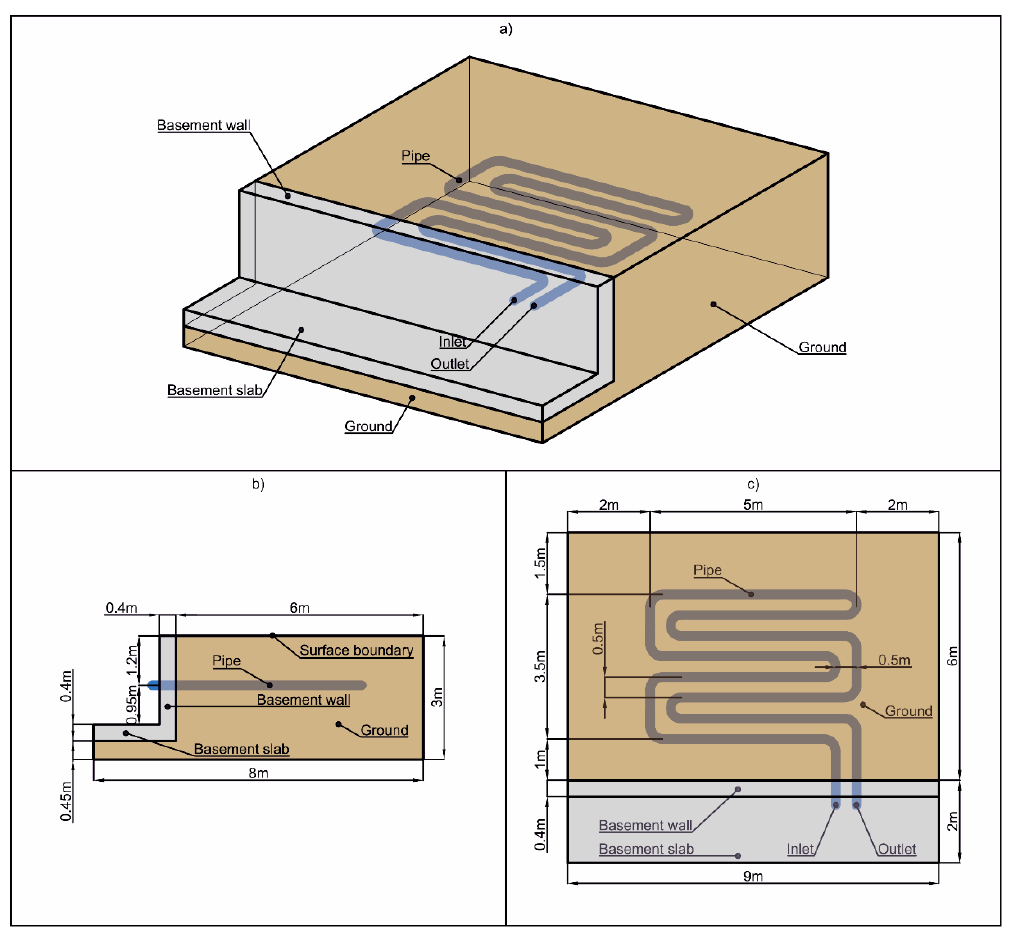
Figure 1. Geometrical model for the HGHE used for numerical simulation: ( a ) tri-dimensional view; ( b ) bi-dimensional side view; ( c ) bi-dimensional top view.